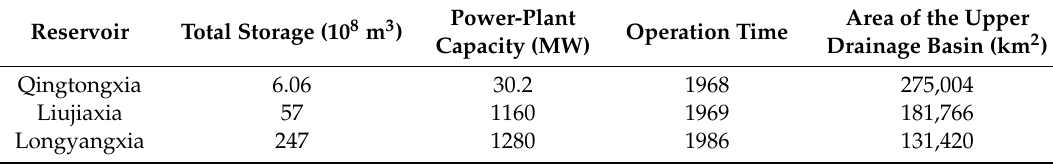
Table 1. Main characteristics of the large reservoir constructed in the Upper Yellow River.